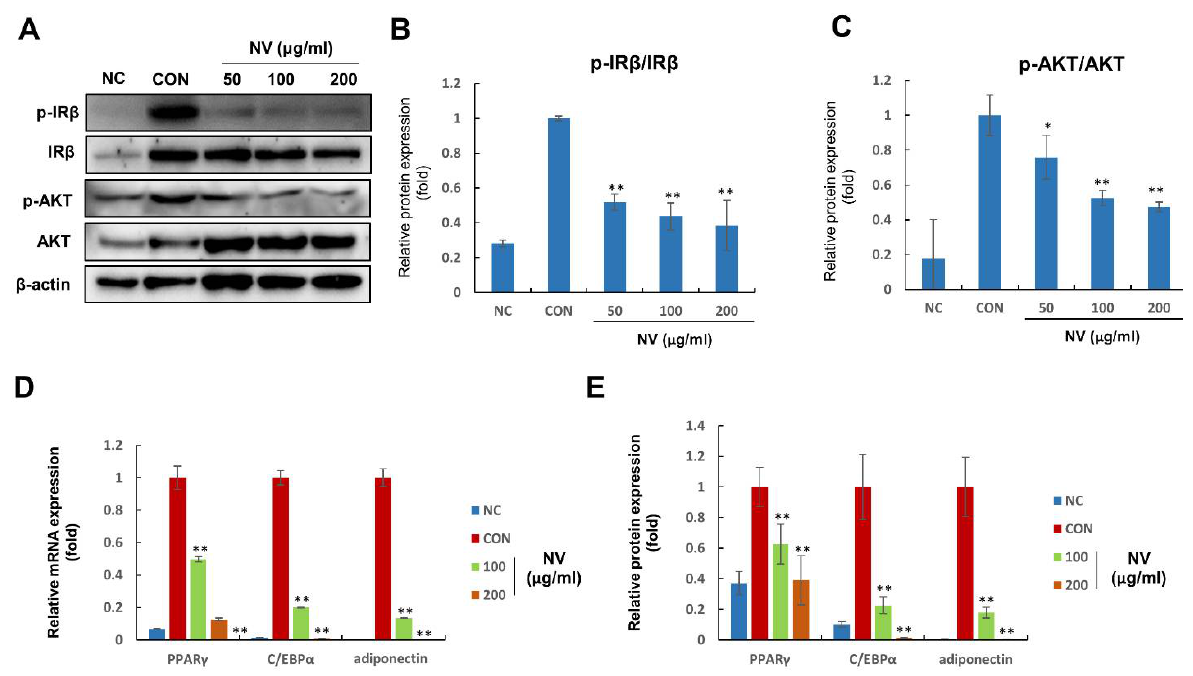
Figure 5. NV modulates the mRNA and protein expression of adipogenesis-related genes in 3T3-L1 adipocytes. 3T3-L1 adipocytes were treated with NV at the indicated concentrations (50, 100, and 200 μg/mL) for 8 days, and total RNA and protein were isolated. Preadipocytes were used as the negative control (NC) and fully differentiated adipocytes were used as the positive control (CON). The NC and CON were treated with the same amount of DMSO instead of NV. ( A – C ) p -IRβ, IRβ, p - AKT, AKT, and β-actin protein expression is shown ( A ). The relative expression was quantified using Fusion Solo Detector software and was expressed as ratios of p -IRβ/IRβ ( B ) and p -AKT/AKT ( C ). ( D , E ) PPARγ, C/EBPα, and adiponectin mRNA ( D ) and protein ( E ) expression is shown. Each experiment was repeated in triplicate. Data are presented as the mean ± standard error of the mean. Significant differences from the CON group are indicated by ** p < 0.01 and * p < 0.05. NV, Nidus vespae extract; IRβ, insulin receptor β; p -IRβ, anti-phosphorylated IRβ; AKT, protein kinase B; p - AKT, phospho-AKT; PPARγ, peroxisome proliferator-activated receptor gamma; C/EBPα, CCAAT/enhancer binding protein alpha.